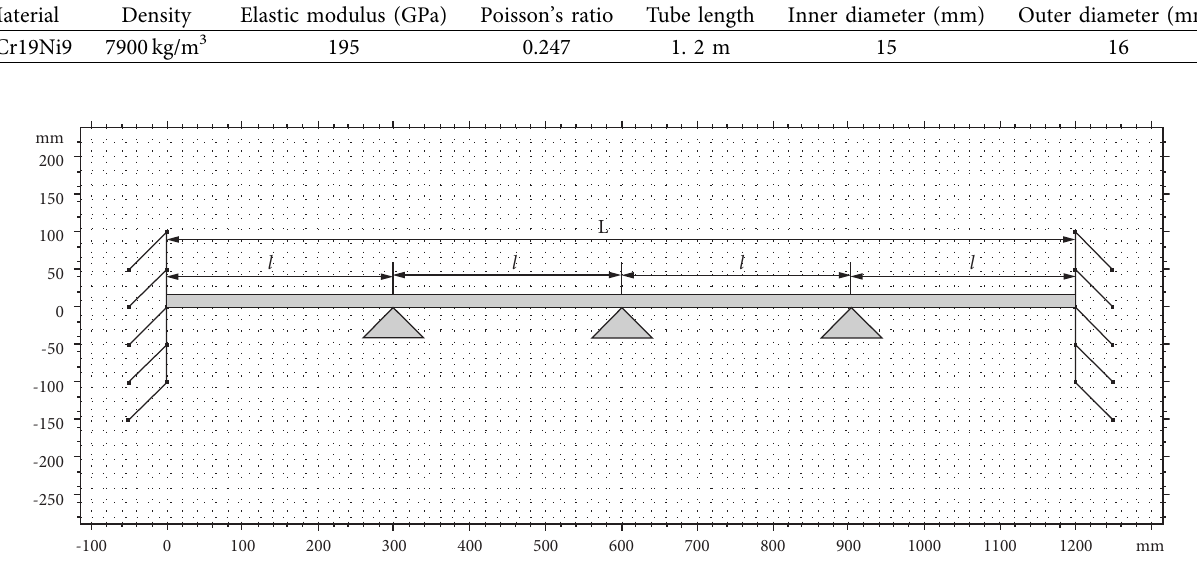
Figure 1: Four-span tube bundle model with the natural frequency.